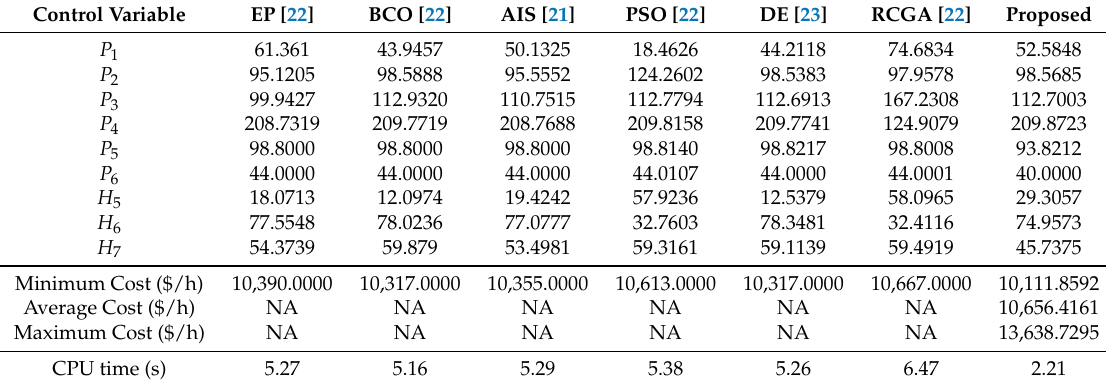
Table 9. Comparison of the obtained results for 7-unit test system (Case